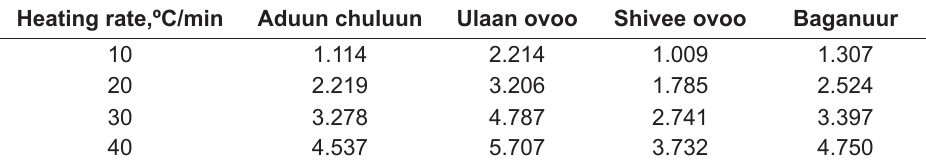
Table 2. Maximum rate of decomposition (%/min) for the coals at the different rates (Zone ΙΙ) Heating